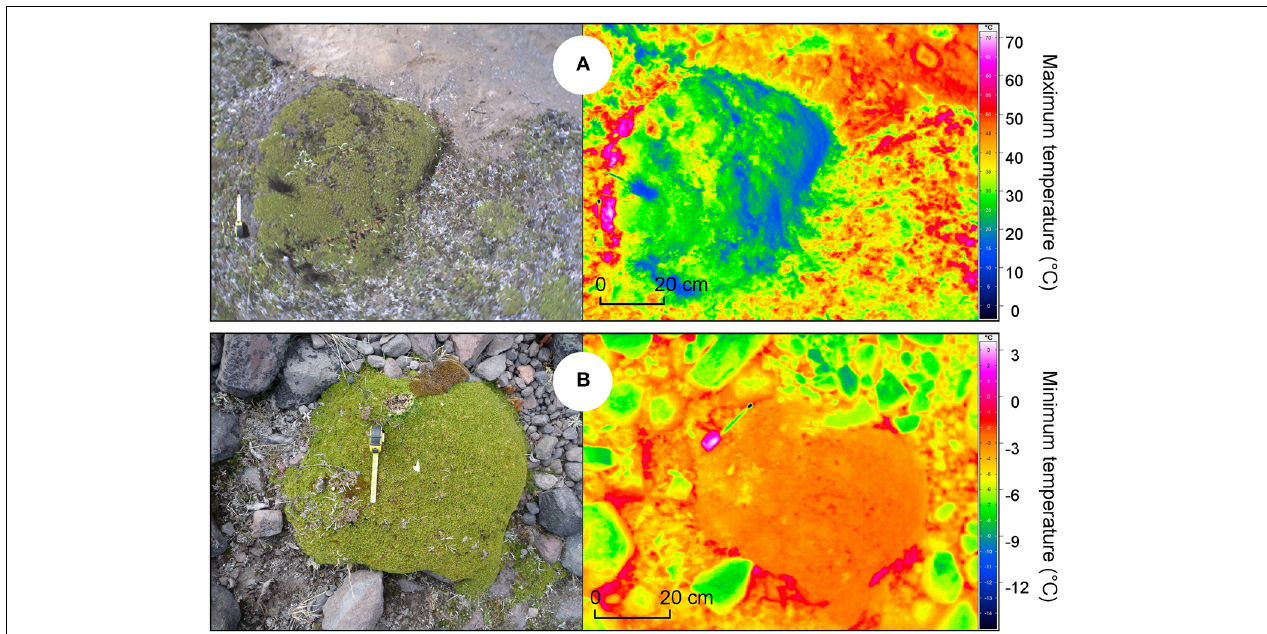
FIGURE 8 | Spatial representation of the buffering effects of the cushion-forming plant Azorella aretioides on temperature (Ecuador, 4700m a.s.l.). (A) A. aretioides mitigates maximum temperature